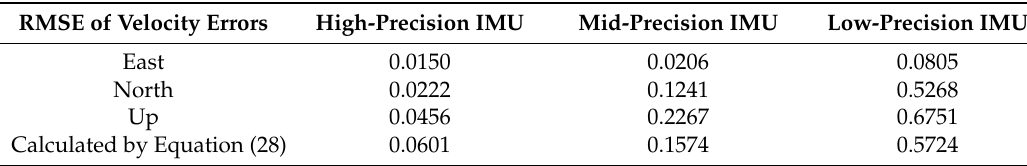
Figure 3. Histogram of root-mean-square errors (RMSEs) of velocity errors. Table 3. RMSEs of the velocity errors in one cycle .